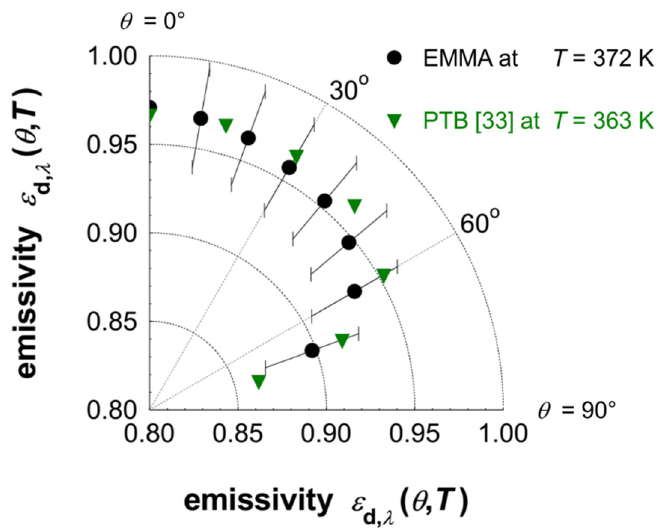
Figure 13. Total directional emissivity of the Nextel-Velvet-Coating 811-21 measured with the EMMA at a temperature of T = 372 K and different emission angles in comparison to published data of PTB derived at T = 363 K [33]. Additionally, the uncertainty bars are given for the values, which have been derived from the EMMA measurements.